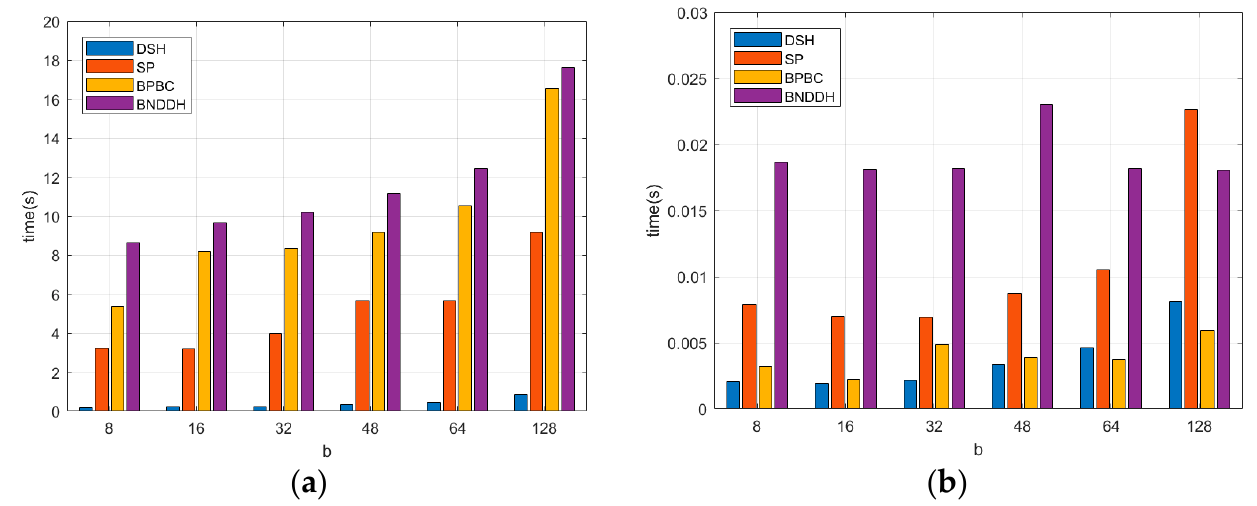
Figure 8. Training time on the MNIST database. ( a ) training time ( b ) testing time.